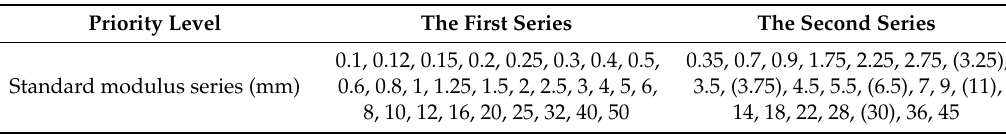
Table 1. Standard module series table (GB/T 1357-1987) .